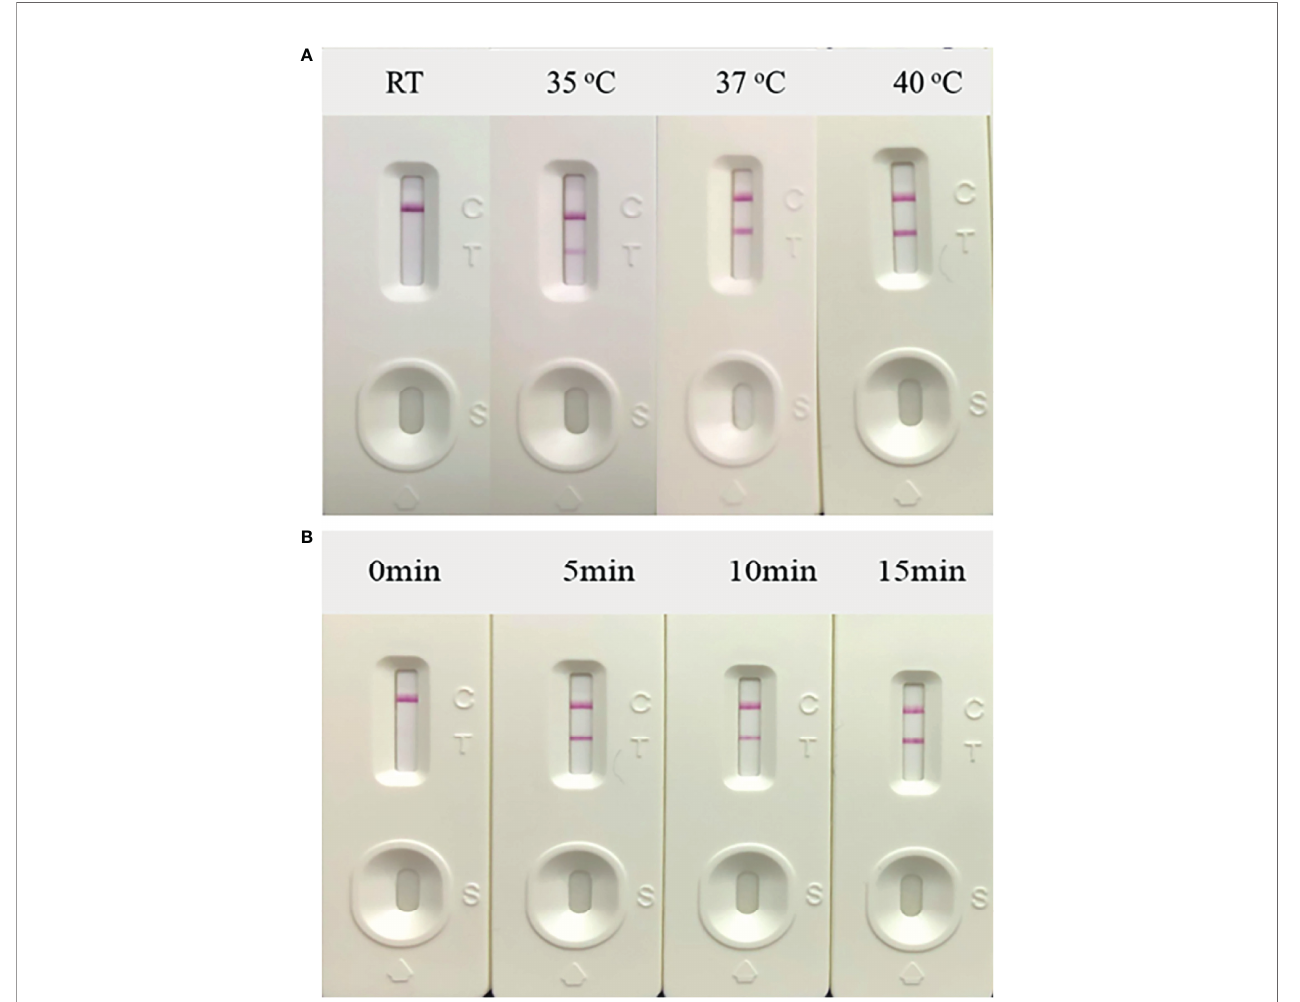
FIGURE 3 | Optimization of reaction conditions. Using the recombinant plasmid PUC57-pC/E1 as a template to optimize the temperature conditions of hepatitis C virus (HCV) reverse transcription recombinase-aided ampli fi cation (RAA) strip. C is the control line, T is the test line, and N is negative control. (A) Determination of the optimal reaction temperature range of the HCV RAA strip. (B) Detection of the optimized ampli fi cation